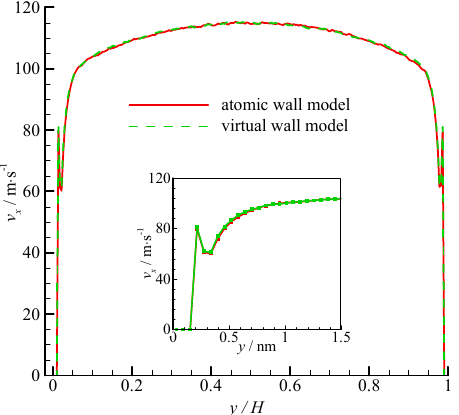
Figure 4. Velocity profiles of the atomic and virtual wall MD simulations across the channel in Poiseuille flow. The non-dimensional wall distance (non-dimensionalized by the channel height H ) is used in large figure, and the dimensional wall distance is used in the zoomed-in figure.